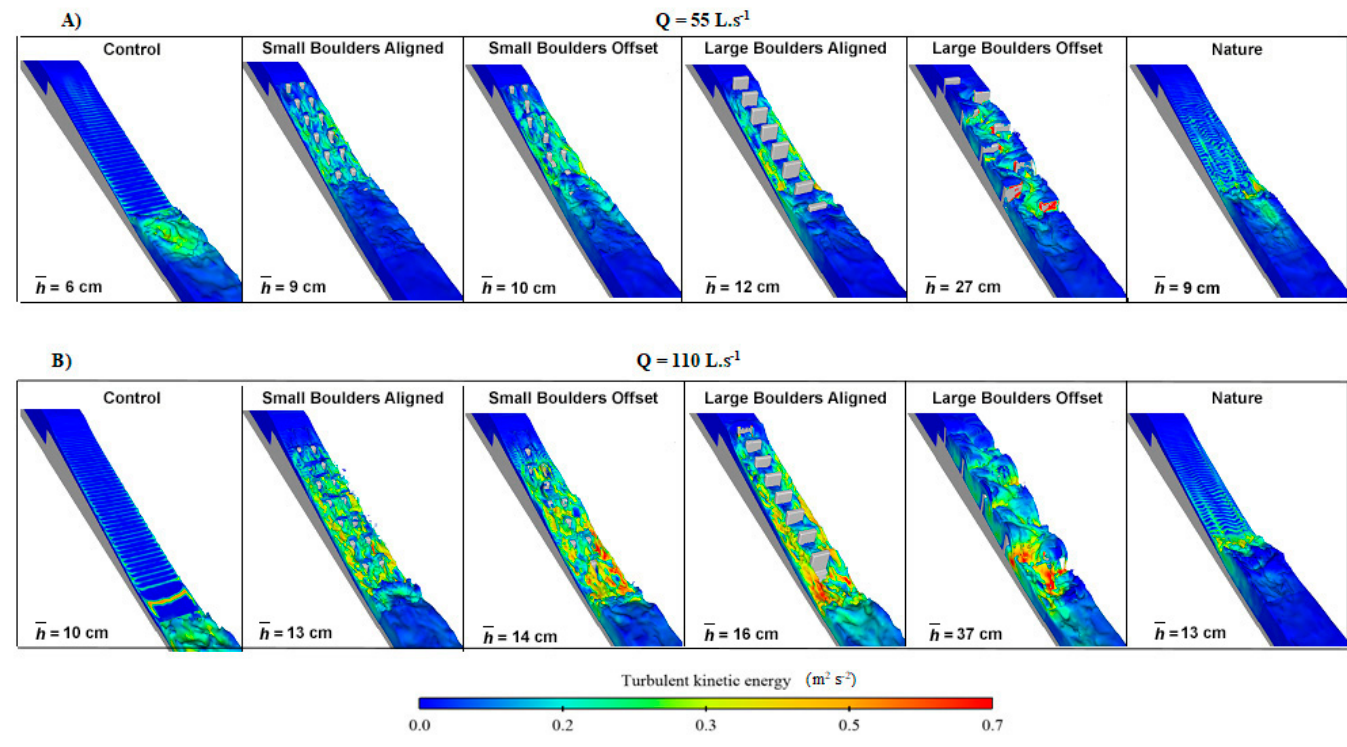
(cid:16) (cid:17) u (cid:48) 2 + v (cid:48) 2 + w (cid:48) 2 ; m 2 · s − 2 ) for each configuration tested, using the computational (cid:2869) 2 (cid:4672)𝑢′ (cid:2870) + 𝑣′ (cid:2870) + 𝑤′ (cid:2870) (cid:4673) ; (cid:2870)